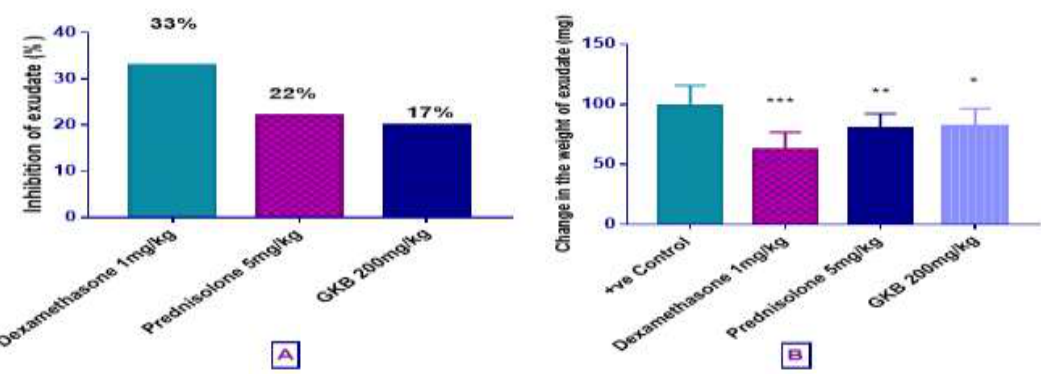
Figure 1: Effect of GKB extract on the percent (A) and weight (B) of exudate in cotton pellet-induced granulomatous inflammation. Values were presented as mean ± S.D (n= 6 animals in each group); values with (*) are significantly different from the positive control using ANOVA and post hoc test (* p < 0.05), (** p < 0.01), and (*** p < 0.001).